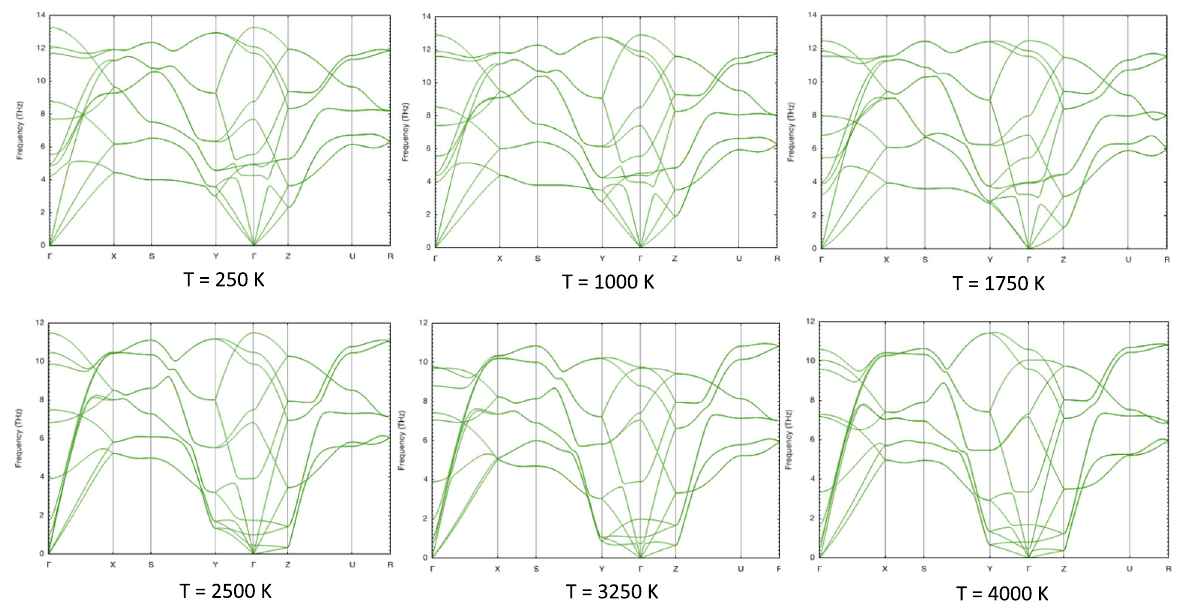
Fig. 7 Phonon spectra of orthorhombic Pnma -Nb at six different temperatures at a fi xed density of 9.95 g cm − 3 . Temperature is indicated under the corresponding phonon spectrum.